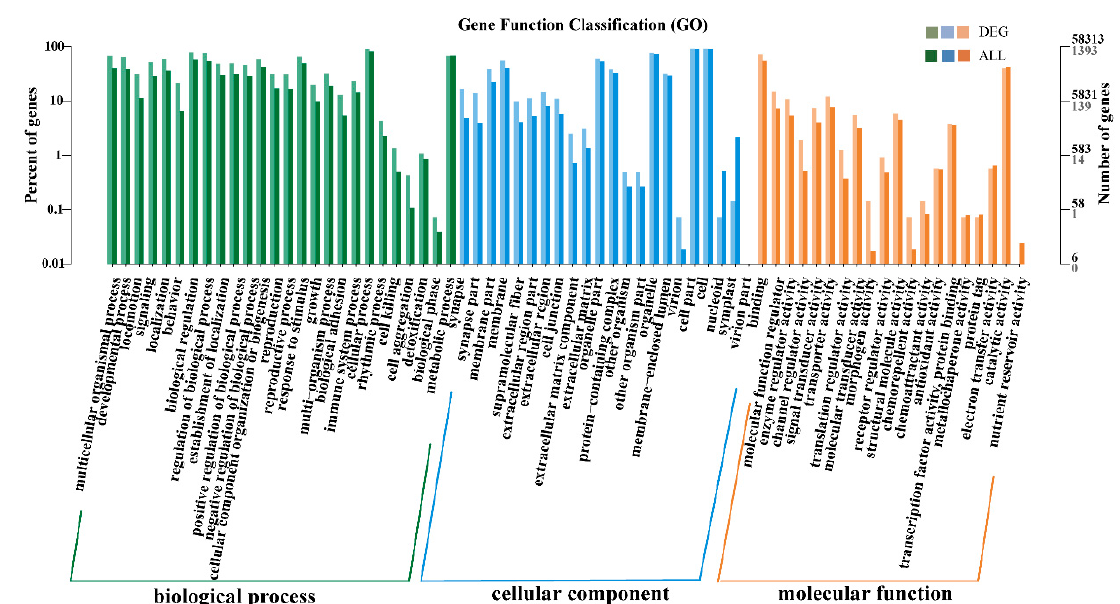
Figure 4. Gene Ontology (GO) functional classification of differentially expressed genes (DEGs) in FW leeches and SW leeches. Distribution of all-unigenes and DEGs among GO terms in biological processes, cellular component, and molecular function.